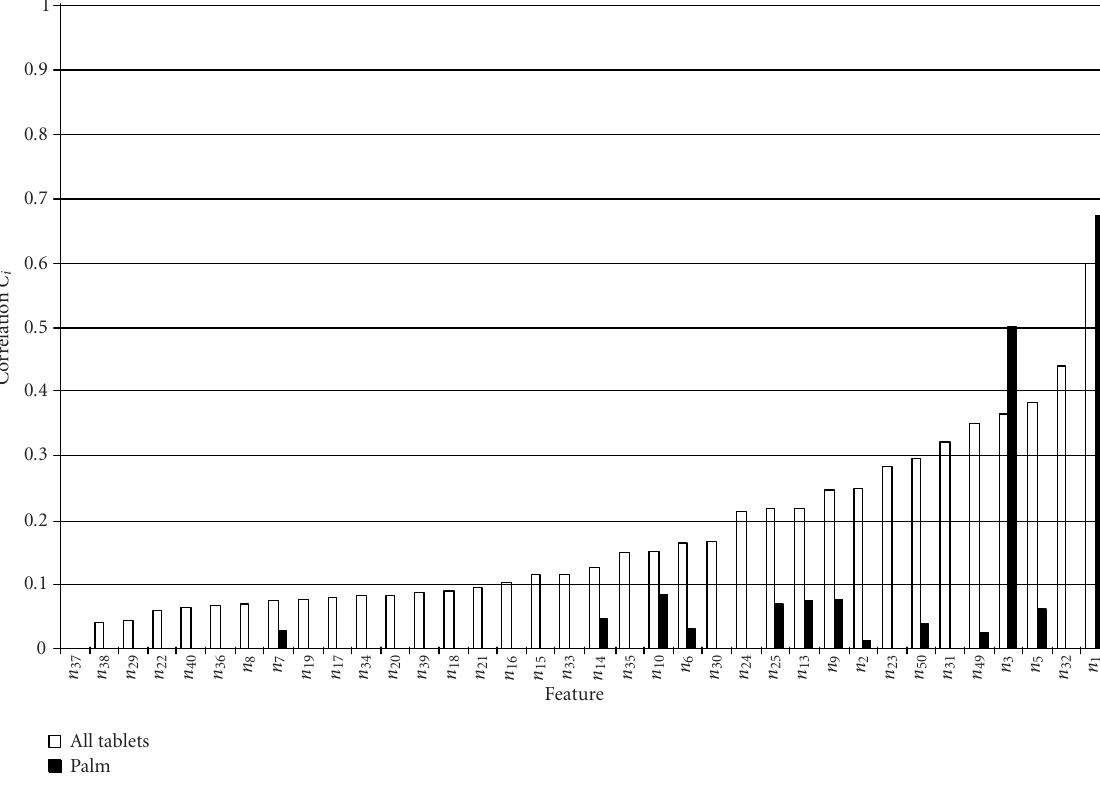
Figure 7: Comparison between stability-entropy correlation of initial and extended